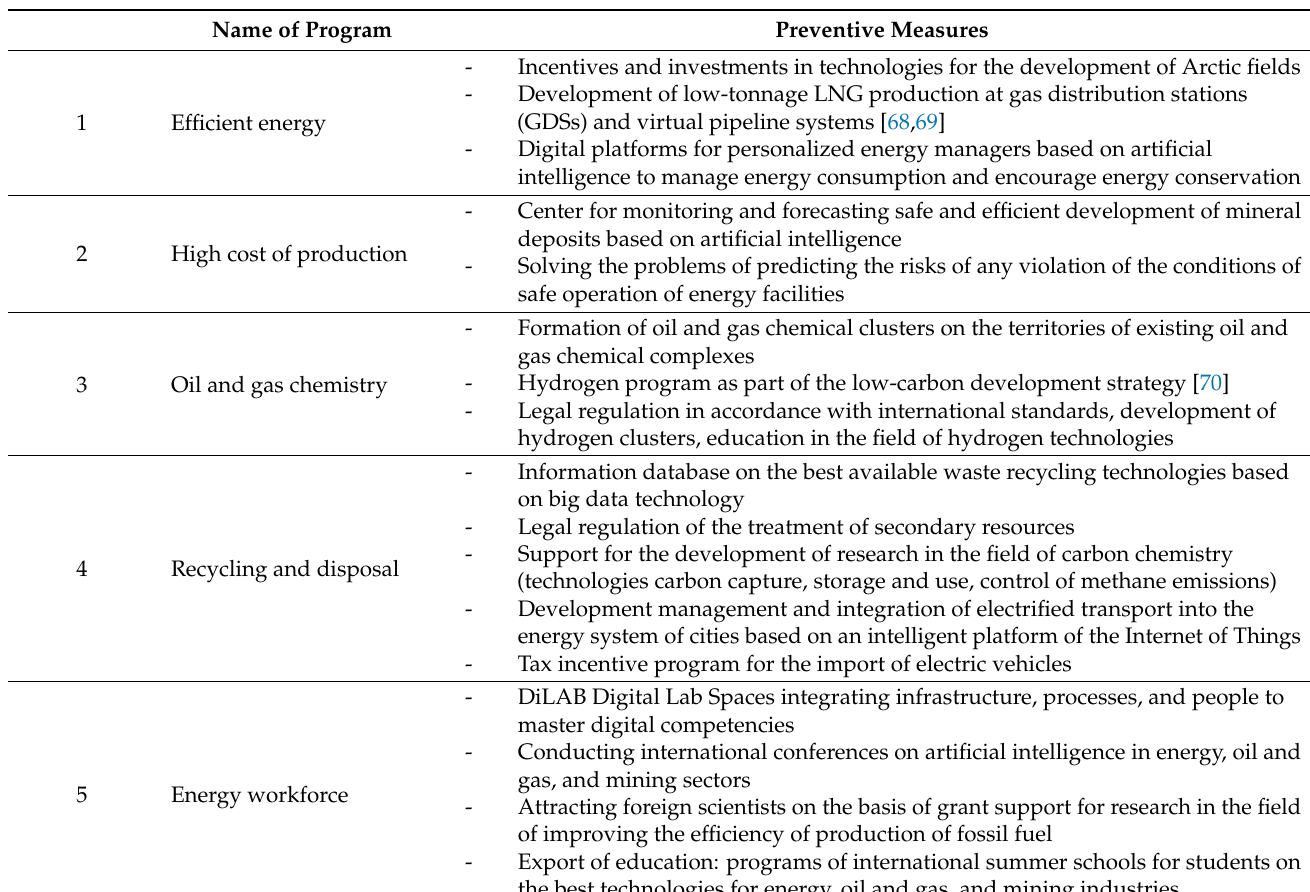
Table 5. The programs of development of the energy